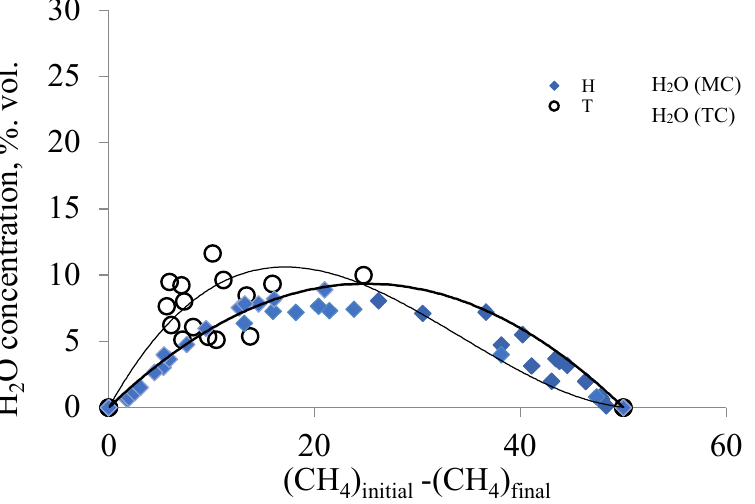
Figure 6. Change in the concentration of water vapor from the amount of the methane consumed on the traditional (TC) and membrane catalysts (MC). (Conditions: T (MC) from 820 ° C to 890 ° C, flow rate of the mixture 30–320 cm3/min; T (TC) from 850 ° C to 900 ° C, flow rate of the reagent mixture 50–150 cm3/min).